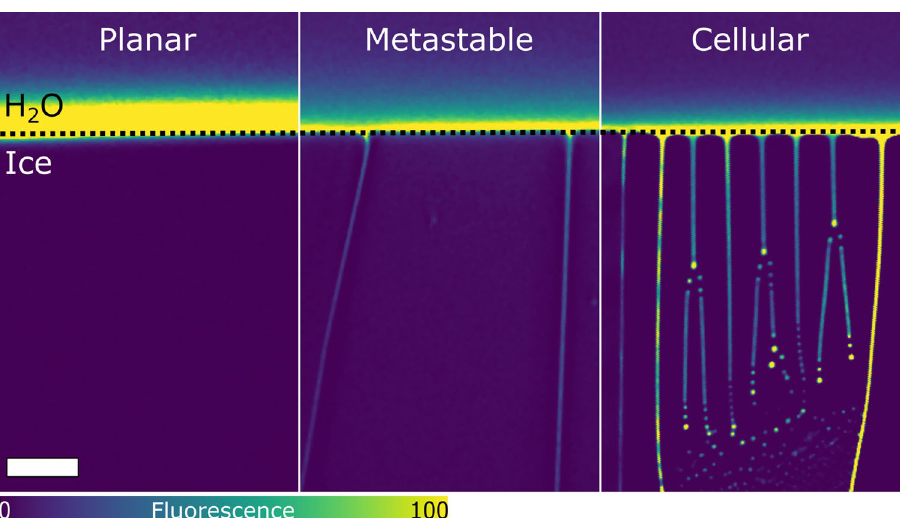
Figure 3. Typical confocal images of directional solidification depicting different front morphologies; planar, metastable, and cellular. Confocal image enables us to distinguish the dark solid phase (ice) from the bright aqueous phase (water). Water is in colormap viridis (fluorescence bar) while ice is in black. Scale bar = 100 µ m . © (2020) S. Tyagi et al. (10.6084/m9.figshare.13176221) CC BY 4.0 license https ://creat iveco mmons .org/licen ses/